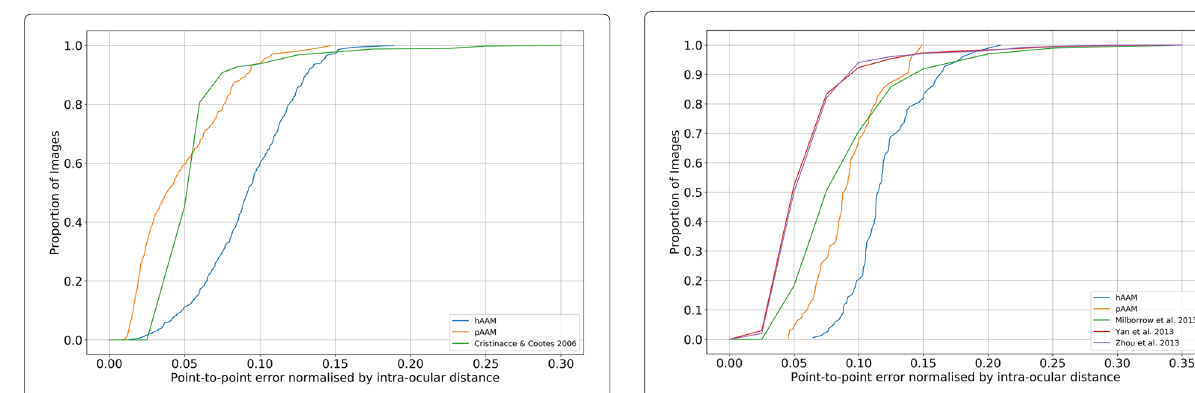
Fig. 11 BioID cumulative error distributions. Comparing the performance of holistic AAMs, patch AAMs, and the performance reported by Cristinacce and Cootes [46]